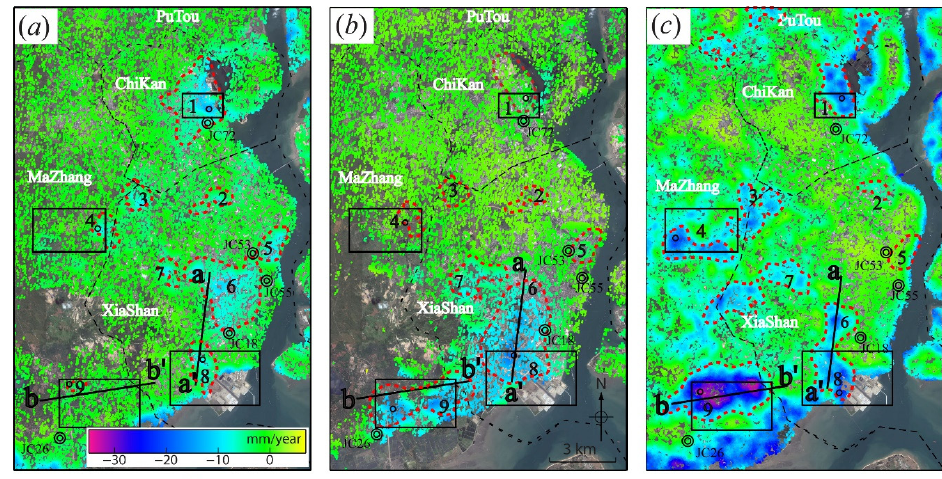
Figure 7. The spatial ‐ temporal evolution of land subsidence in Zhanjiang city. ( a ) Average subsidence rate of JERS from Octorber 1992 to September 1998; ( b ) average subsidence rate of ENVISAT from October 2003 to May 2007; ( c ) average subsidence rate of ALOS1 from December 2006 to July 2010. Zhanjiang city consists of four districts, namely Chikan, Xiashan, Potou, and Mazhang. Black dashed lines indicate the district border. Areas marked with red dashed lines are land subsidence bowls; Black circles are the leveling stations and two black solid lines are selected profiles of the subsidence bowl by aa’ and bb’. Table 1. Area of subsidence bowls in Figure 7.